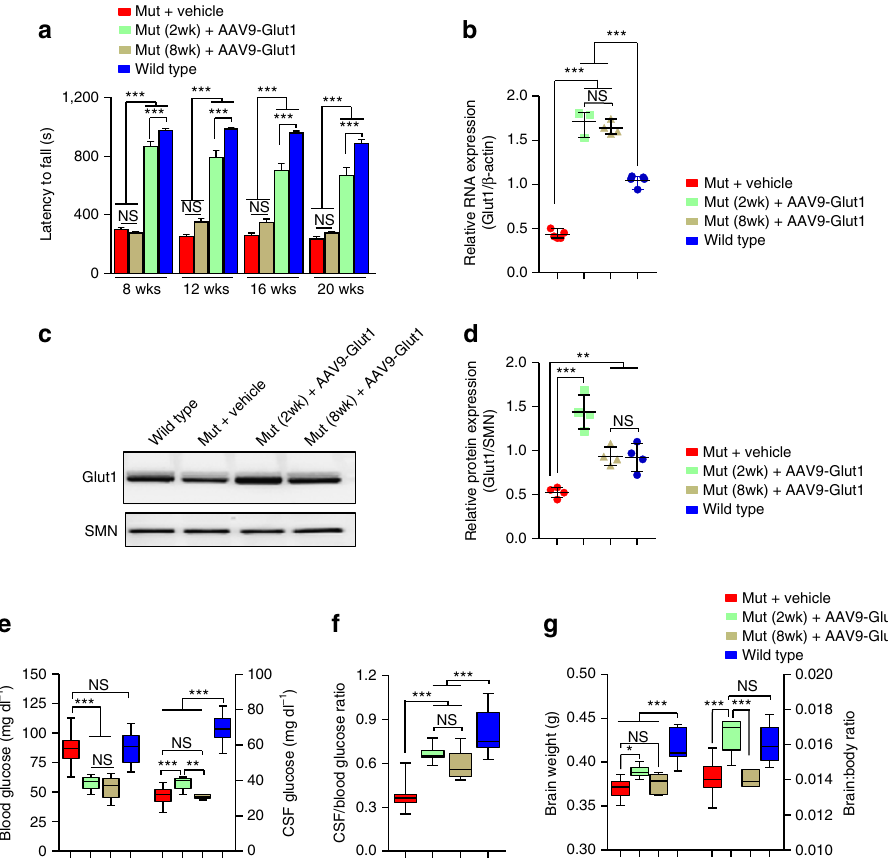
Figure 6 | A defined window of opportunity to treat Glut1 DS. ( a ) Rotarod tests reveal significantly improved motor performance of mutant mice treated with the therapeutic vector at 2 weeks but not 8 weeks of age. ***, P o 0.001, one-way ANOVA, N Z 8 mice in each cohort. Late delivery of the AAV9-Glut1 to mutant mice does not preclude an increase in ( b ) Glut1 RNA expression or ( c , d ) Glut1 protein as assessed by western blot analysis. **, ***, P o 0.01 and P o 0.001, one-way ANOVA, N Z 4 mice in each cohort. An evaluation of ( e , f ) blood and CSF glucose values and ( g ) micrencephaly in mutant mice treated at either 2 or 8 weeks of age. *, ***, P o 0.05 and P o 0.001, one-way ANOVA, N Z 8 mice in each